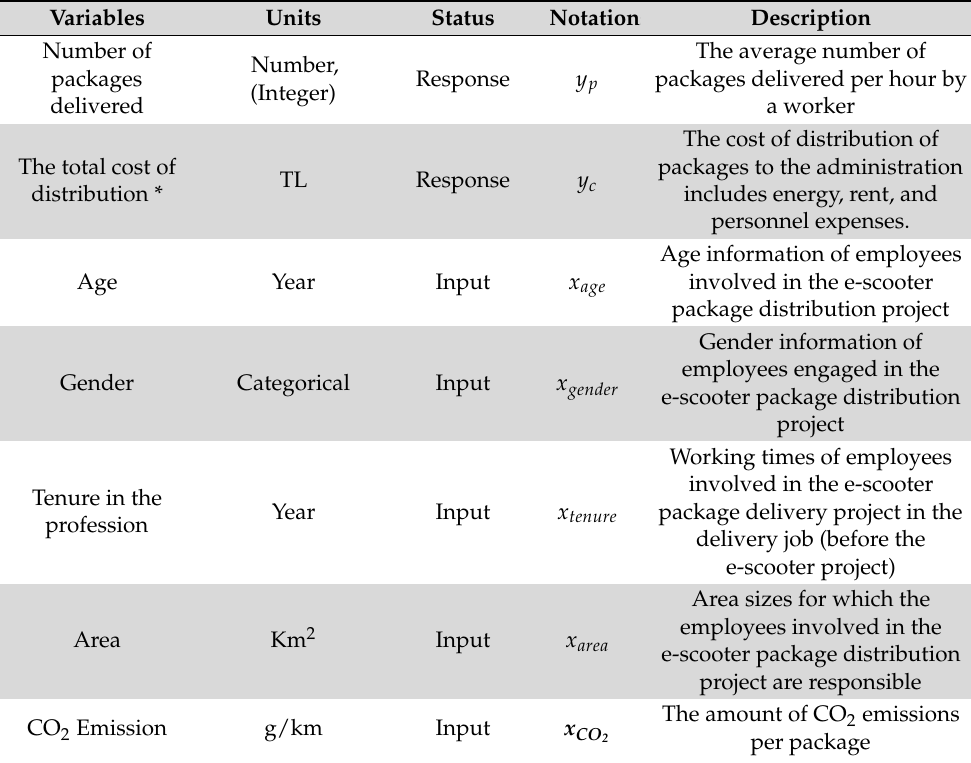
Table 2. Indicators of the packages delivered by the